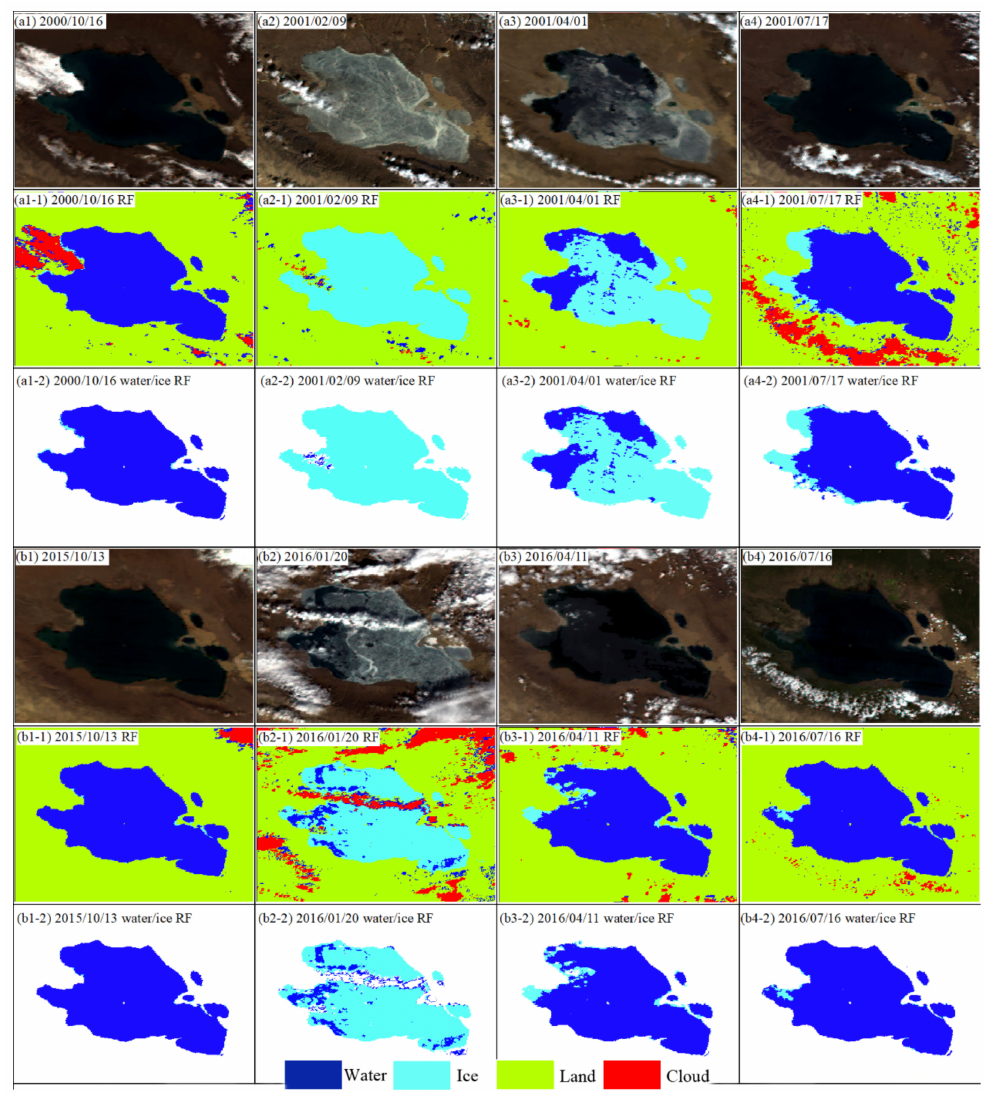
Figure 3. Output classes of four seasons during the 2000 / 2001 and 2015 / 2016 ice season with cloud cover for 16 October 2000 ( a1 , a1-1 , a1-2 ), 9 February 2001 ( a2 , a2-1 , a2-2 ), 1 April 2001 ( a3 , a3-1 , a3-2 ), 17 July 2001 ( a4 , a4-1 , a4-2 ), 13 October 2015 ( b1 , b1-1 , b1-2 ), 20 January 2016 ( b2 , b2-1 , b2-2 ), 11 April 2016 ( b3 , b3-1 , b3-2 ), 16 July 2016 ( b4 , b4-1 , b4-2